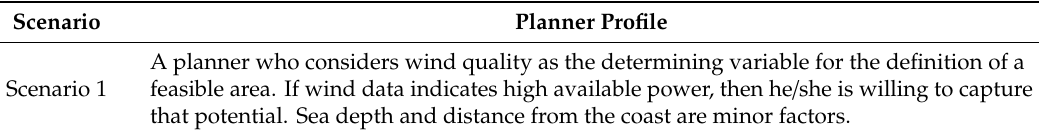
Table 4. Description of weight attribution profiles for each produced scenario.